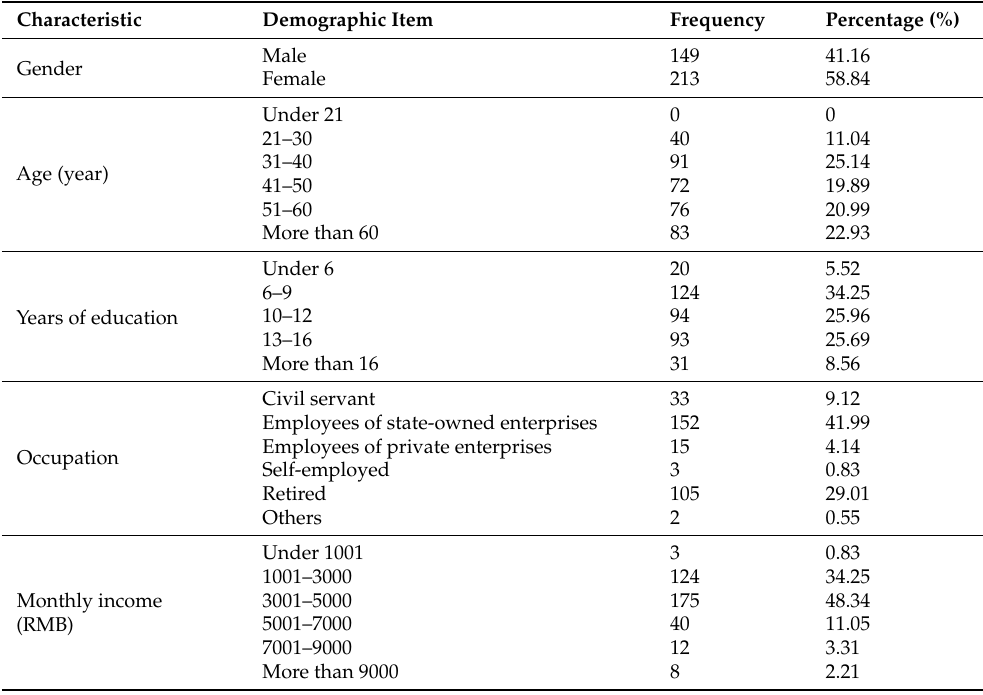
Table 1. Demographic characteristics of respondents.